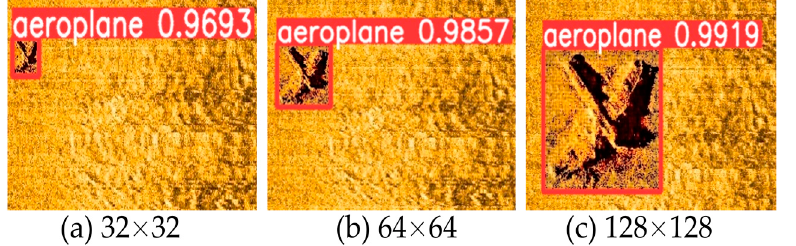
Figure 20. Difference size on same target. ( a ) target size is (32,32); ( b ) target size is (64,64); ( c )target size is size is (128,128)